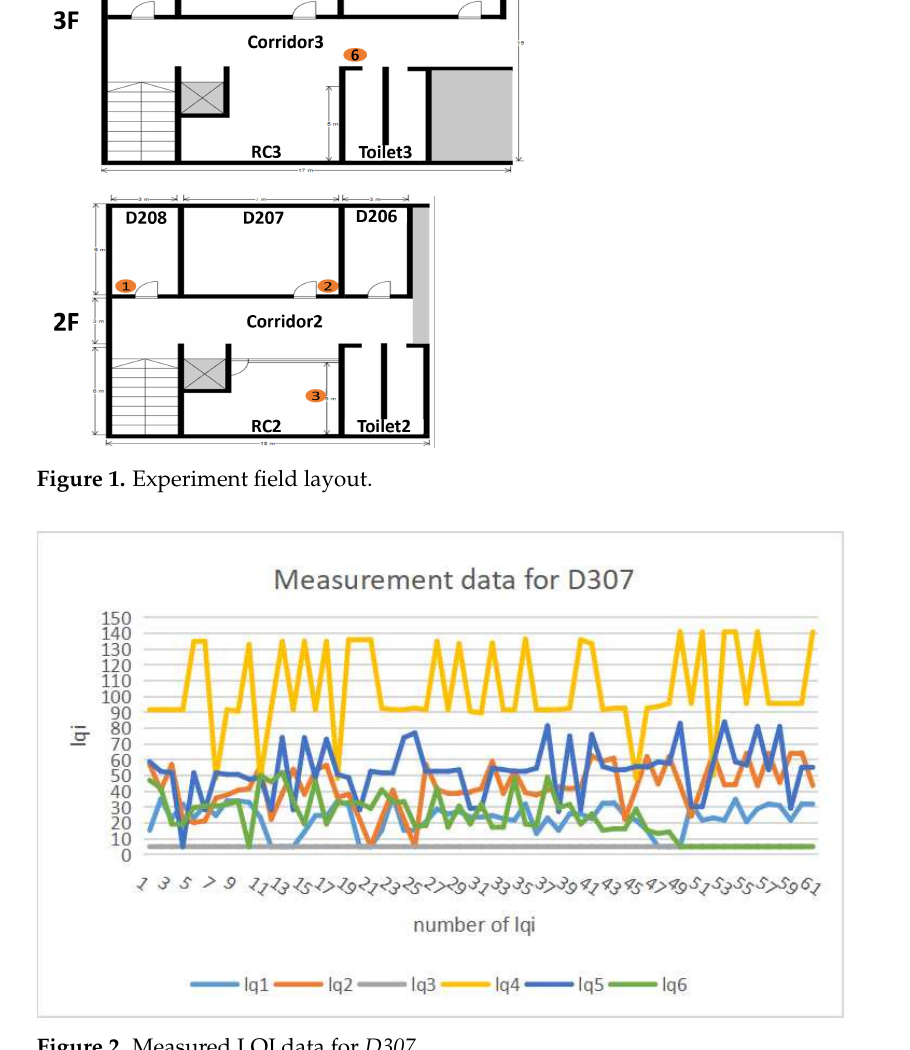
Figure 2. Measured LQI data for D307